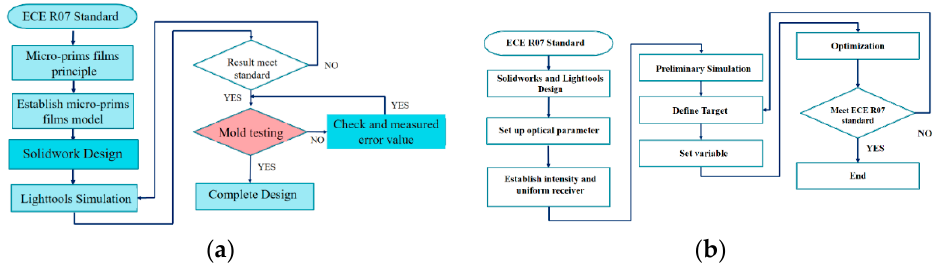
Figure 7. The flowchart of ( a ) the proposed rear light simulation; ( b ) the prism structure optimization.